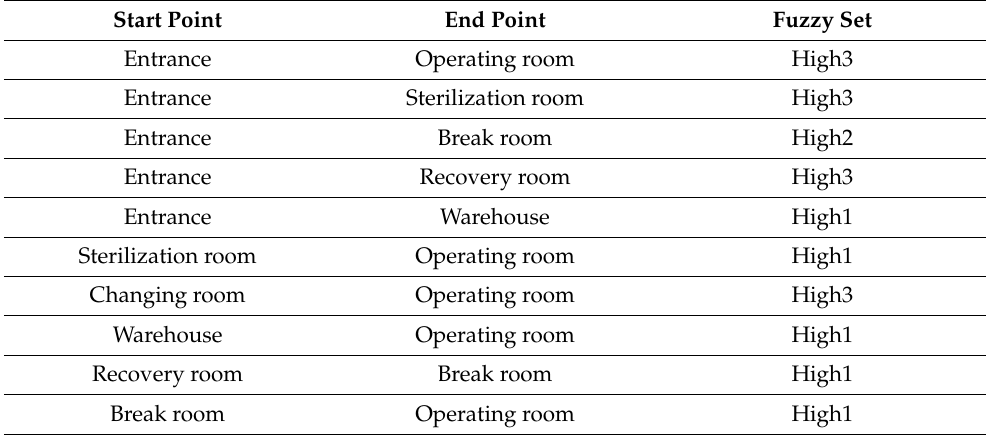
Table 8. Paths and their respective fuzzy